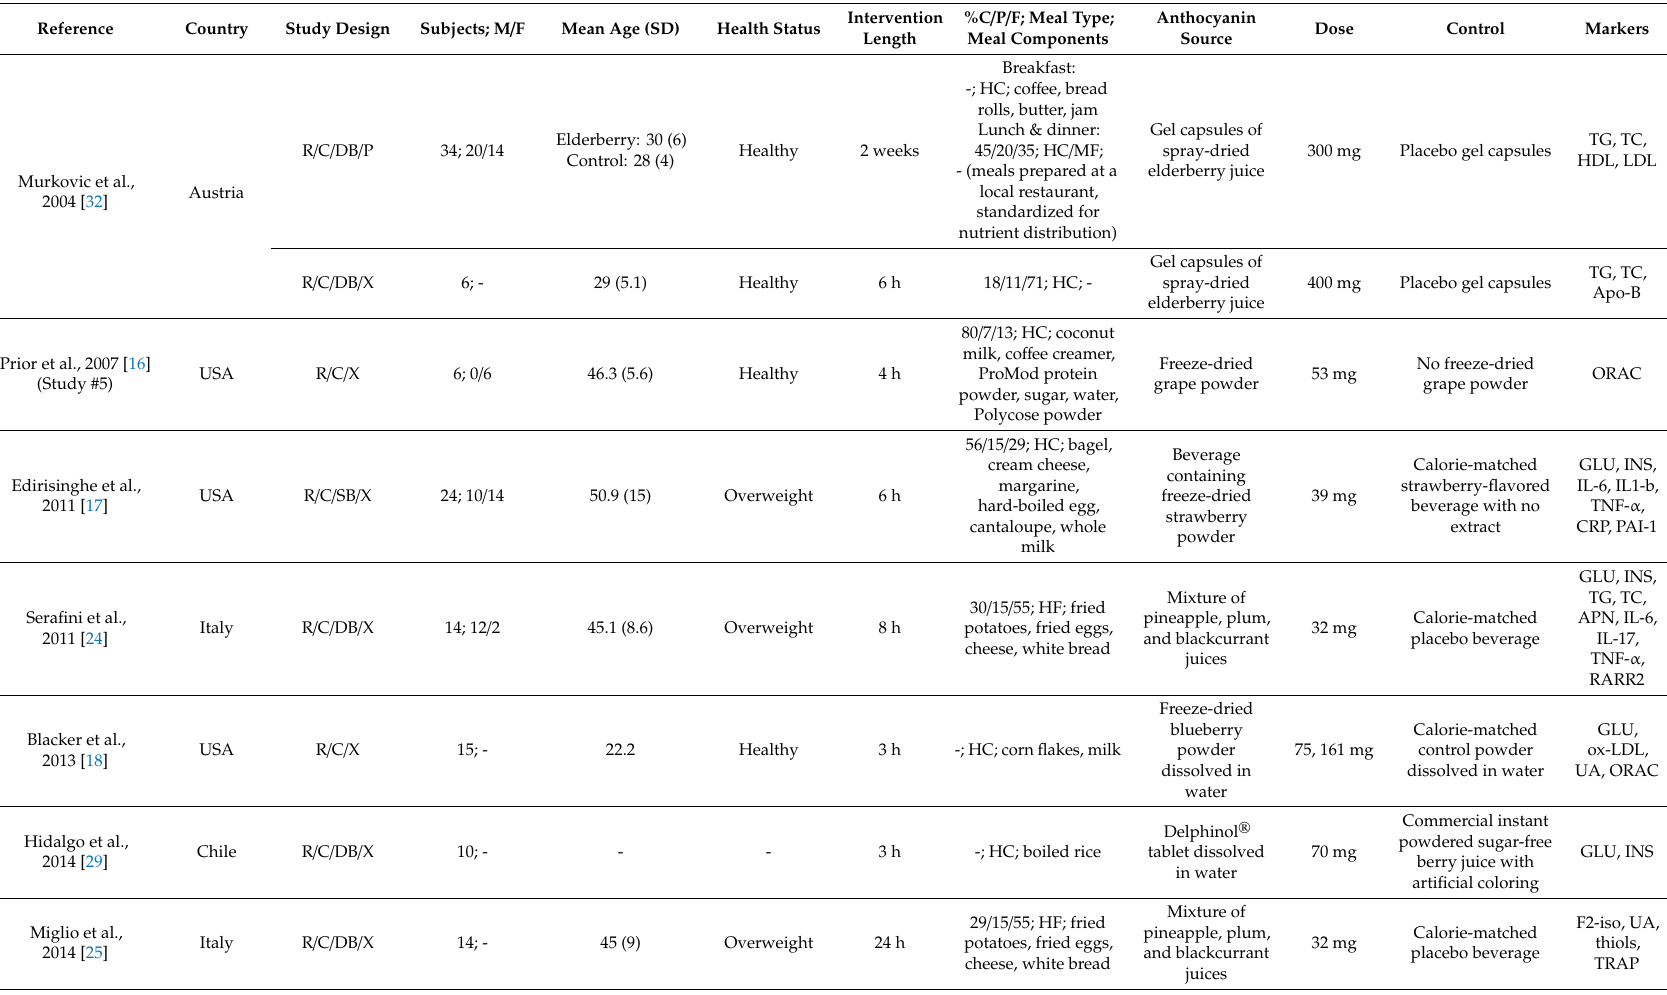
Table 1. Characteristics of 20 included nutritional intervention studies on anthocyanin intake and cardiometabolic health in controlled feeding